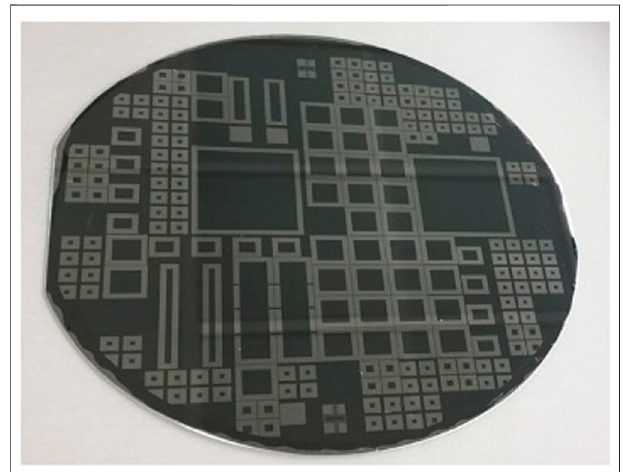
FIGURE 3 | SLAC planar sensor wafer processed at the Stanford Nanofabrication Facility (SNF). The entrance window with patterned metal is